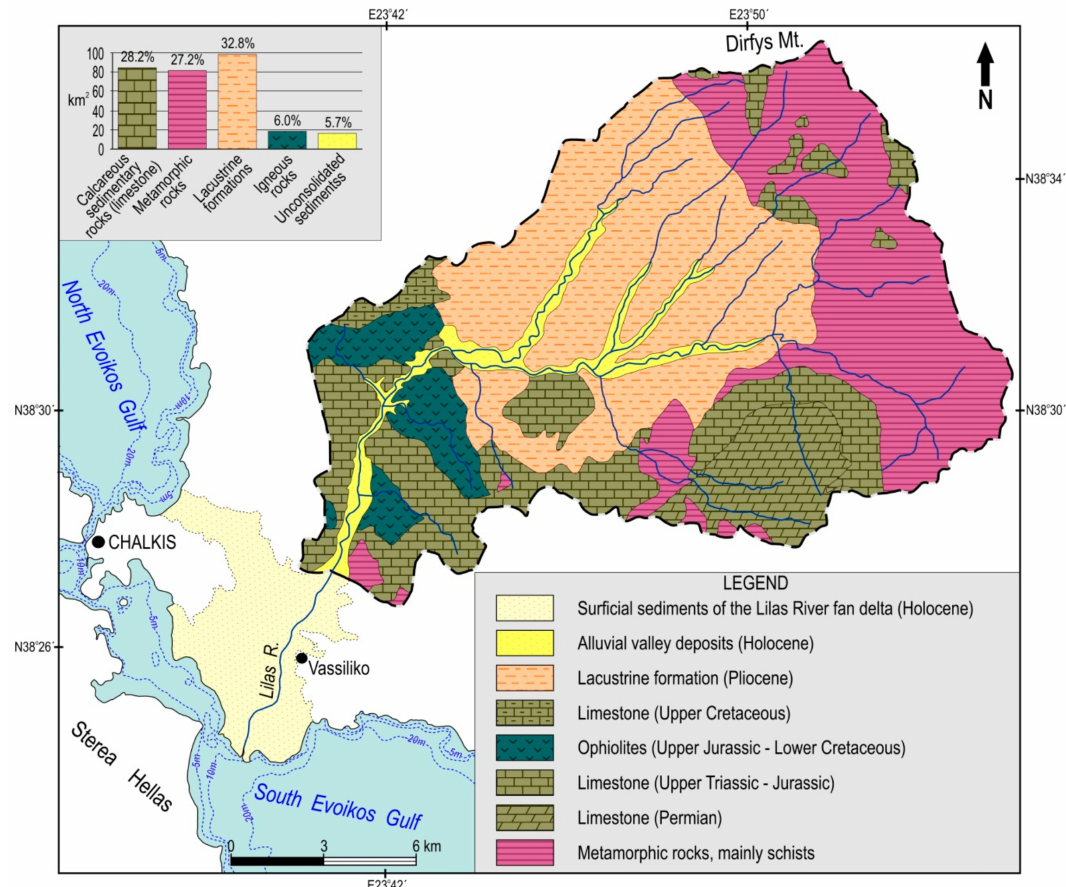
Figure 2. Simplified lithological map of the Lilas River drainage basin with a diagram showing the percentage area of each one of the lithological types in the catchment. It is based on the Greek Institute of Geology and Mineral Exploration (IGME) 1:200,000 scale geological map of Greece [38]. Water depths over the South Evoikos Gulf range from 20 to 68 m and the seafloor relief is characterized by low gradients (1:1000)